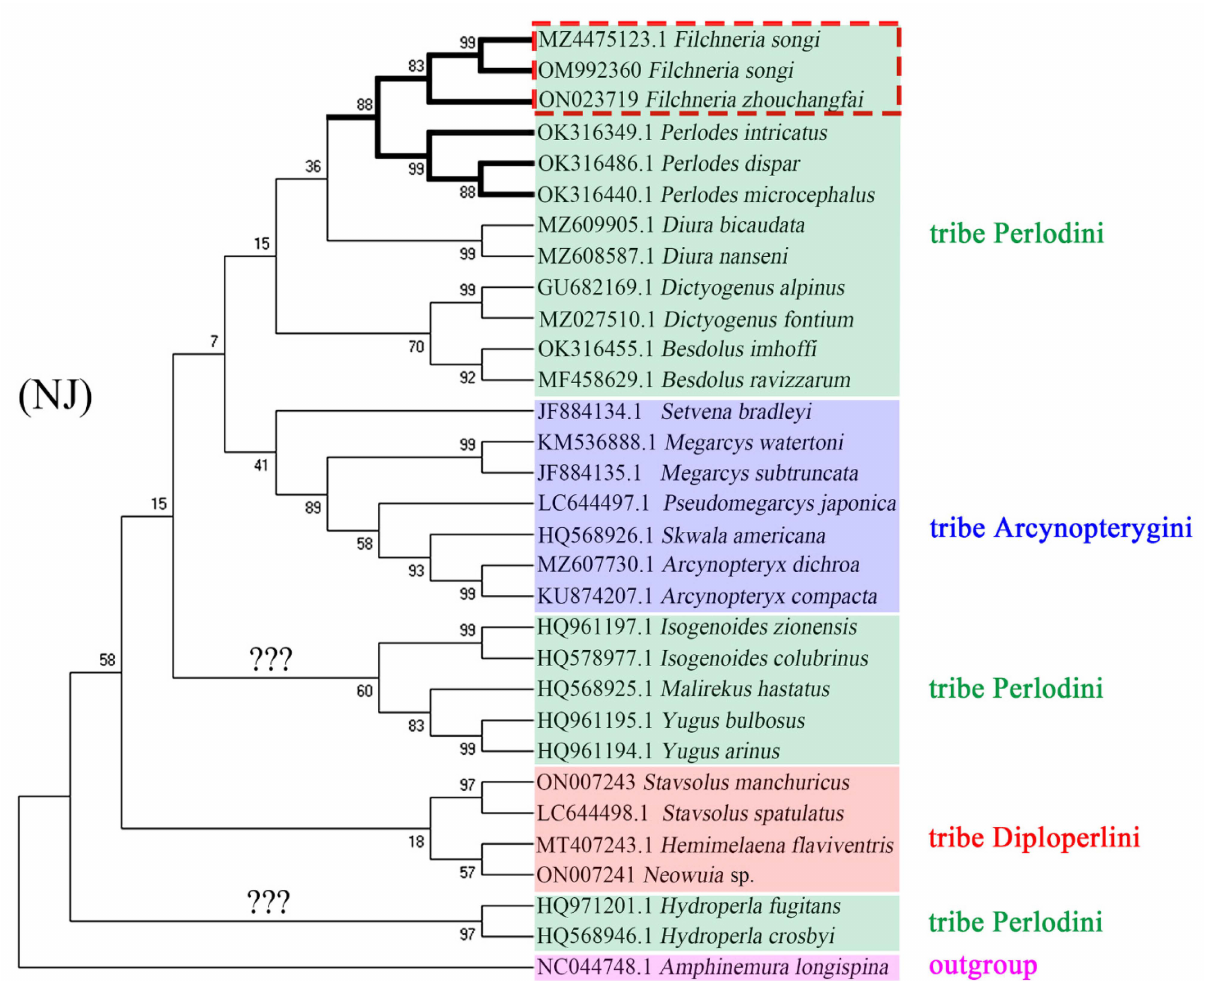
Figure 15. Phylogenetic relationships of Perlodinae, based on the neighbor‑joining (NJ) method. The monophyly of the tribe Perlodini is not supported